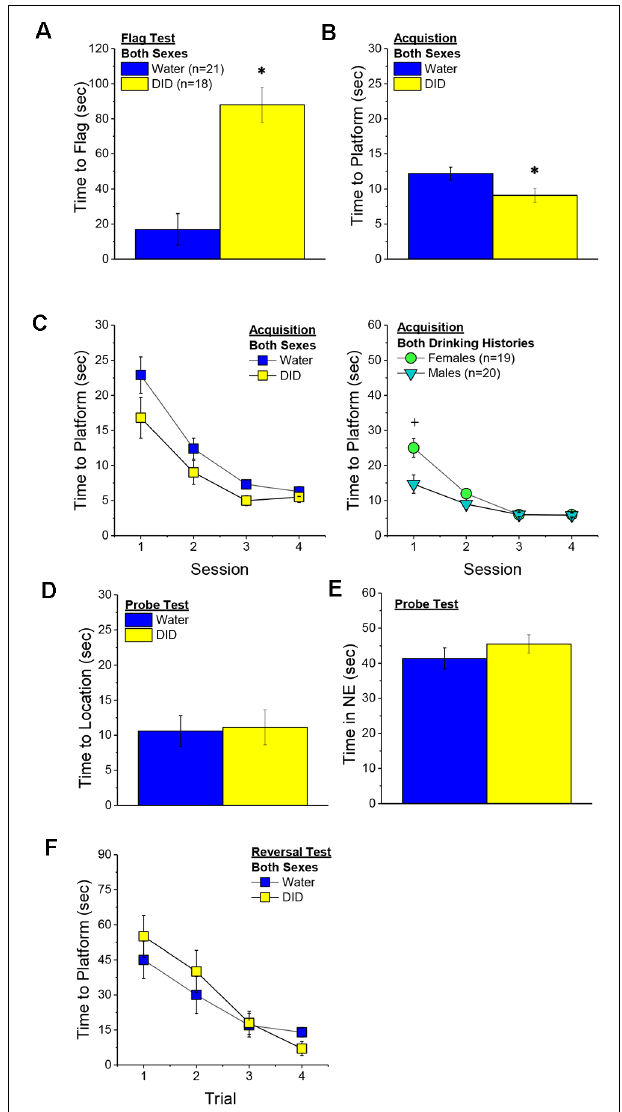
FIGURE 3 | Effects of binge drinking during later maturity (6–9 months of age) on Morris water maze performance in a heterogenous cohort of mice. Relative to water-drinking controls (Water), the binge drinking mice (DID) in Experiment 1 exhibited a longer latency to locate a visible, flagged, platform (A) , but an average shorter latency to locate the hidden platform during the acquisition phase of the study (B) . (C) Comparison of the time-course of spatial learning in the Morris water maze between DID and Water animals collapsed across sex (left) and between males and females, collapsed across drinking history (right) . On the probe test, no group differences were detected for the latency to first enter the former platform location (D) or the total time spent in the NE quadrant that formerly contained the platform (E) . (F) No group differences were detected for reversal learning then the hidden platform is moved to a new location in the maze. The data represent the means ± SEMs, adjusted for the covariates of age and background, of the number of mice indicated in parentheses. ∗ p < 0.05 DID vs. Water; + p < 0.05 Females vs. Males.